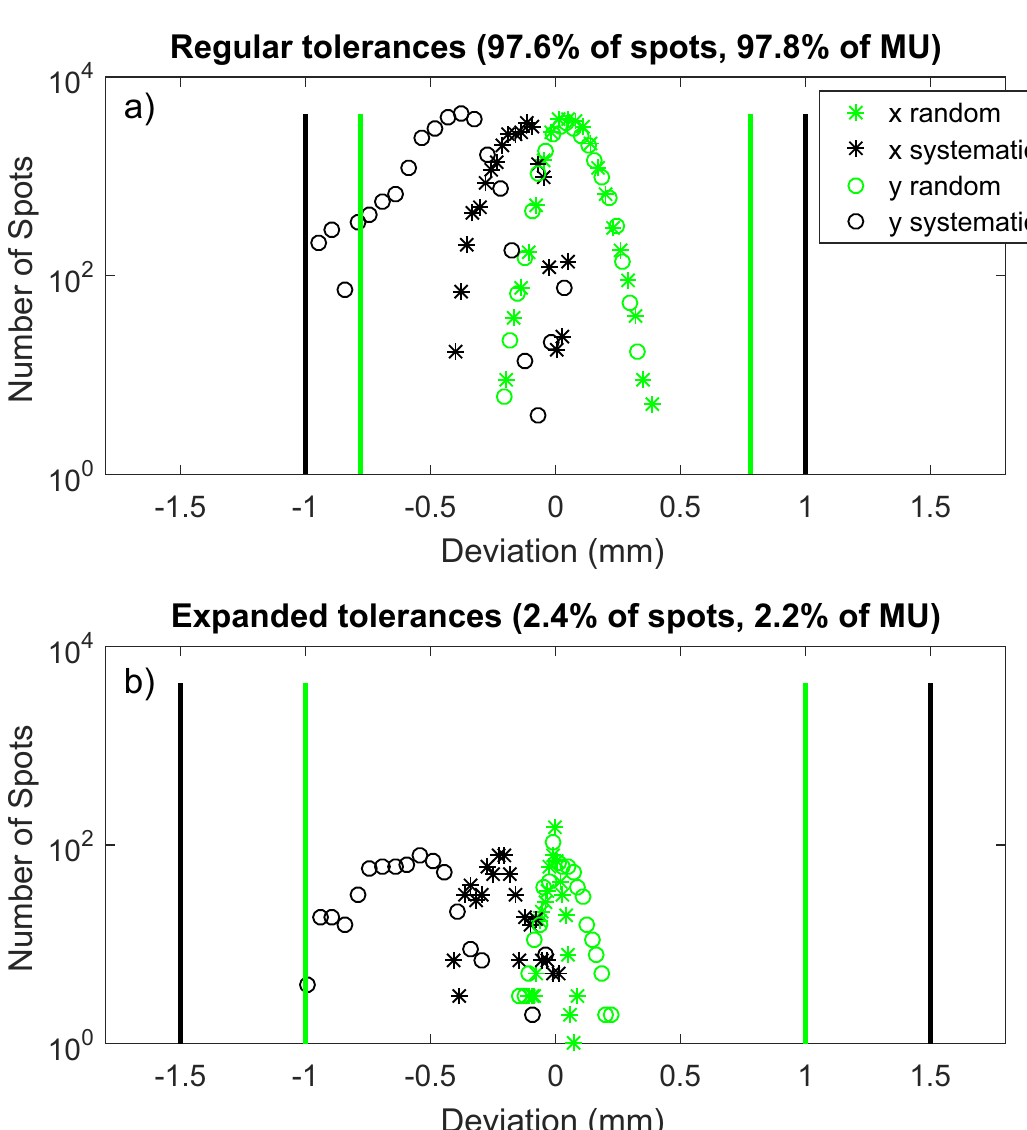
Fig 5. Projected spot position deviation histograms for a sub-optimal plan delivery. The systematic and random components of the error (Eqs 1 and 2) are shown on log-linear histograms. Spots subject to regular tolerances (a) are separated from those governed by expanded tolerances (b). The close approach of the y systematic data points to their corresponding tolerance (black line) suggests the potential for triggering a machine interlock during subsequent deliveries of this plan.